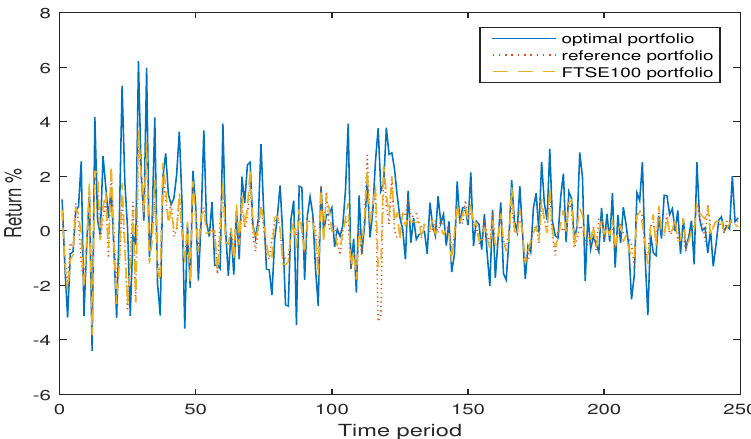
Figure 13. The return of optimal portfolio by ε BBO in each period with benchmark portfolio and the FTSE100 Index portfolio in X ∈ [ − 0.05,0.15 ] of model